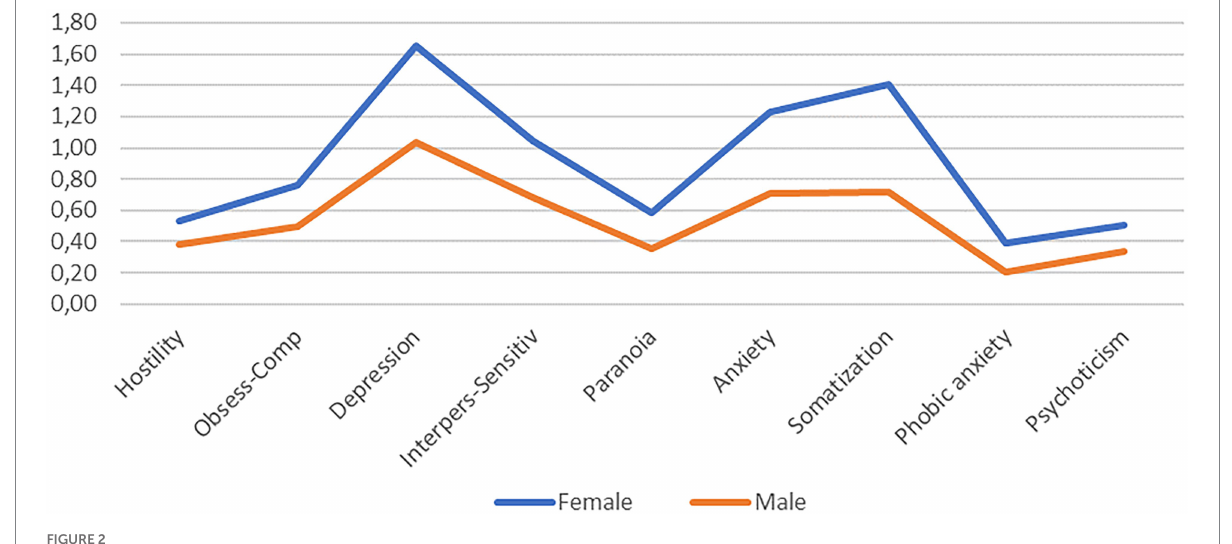
FIGURE 2 SCL-K-9 single-item analysis. Gender-specific GSI mean